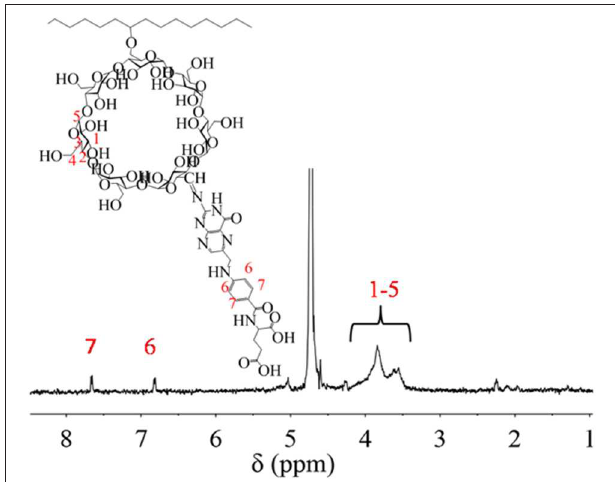
FIGURE 7 | 1 H NMR spectrum of